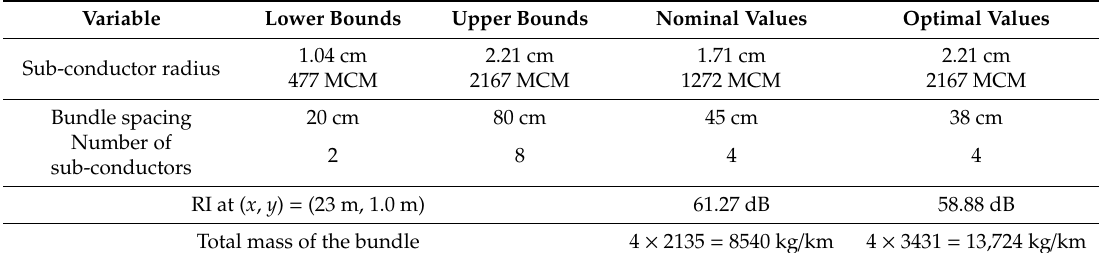
Table 6. Optimal geometric parameters for ± 600 kV HVDC